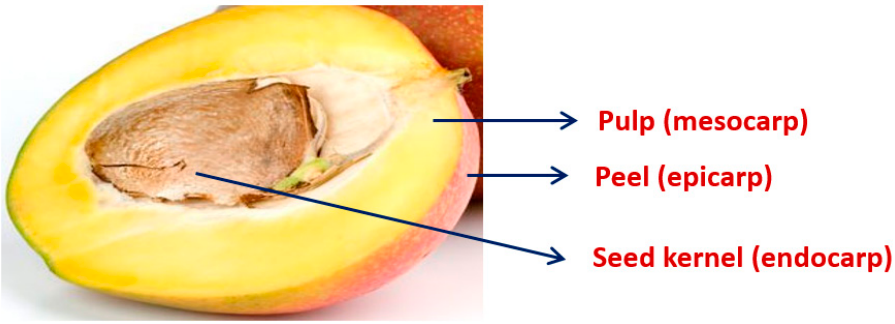
Figure 2. Major parts of mango fruit.